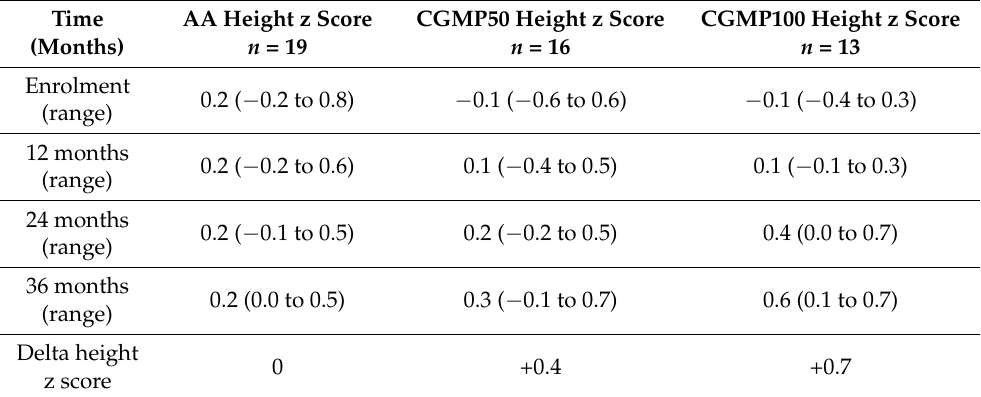
Table 3. Median z scores (range) for height in AA, CGMP50 and CGMP100 groups measured